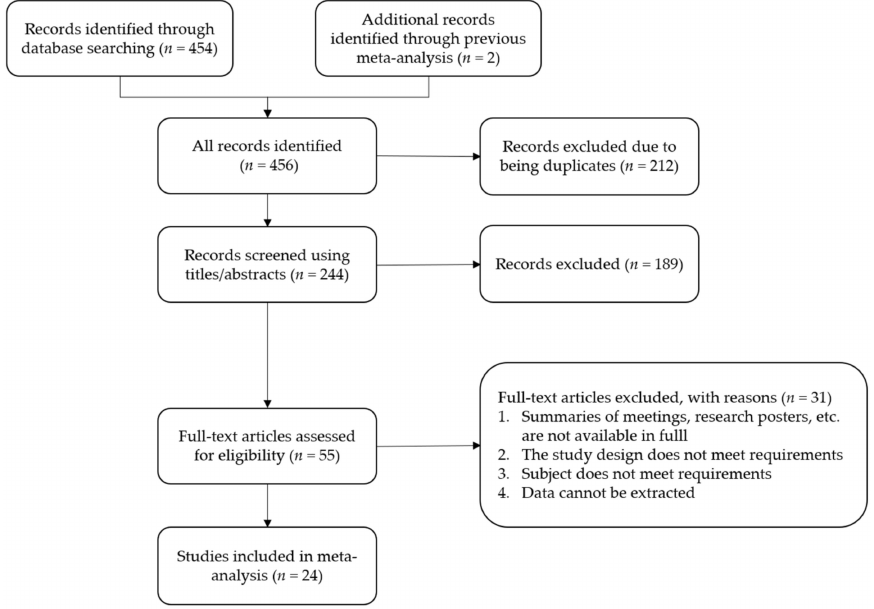
Figure 1. Flowchart of the literature